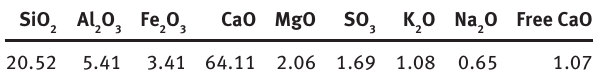
Table 1 Chemical analyses of OPC ( % ).